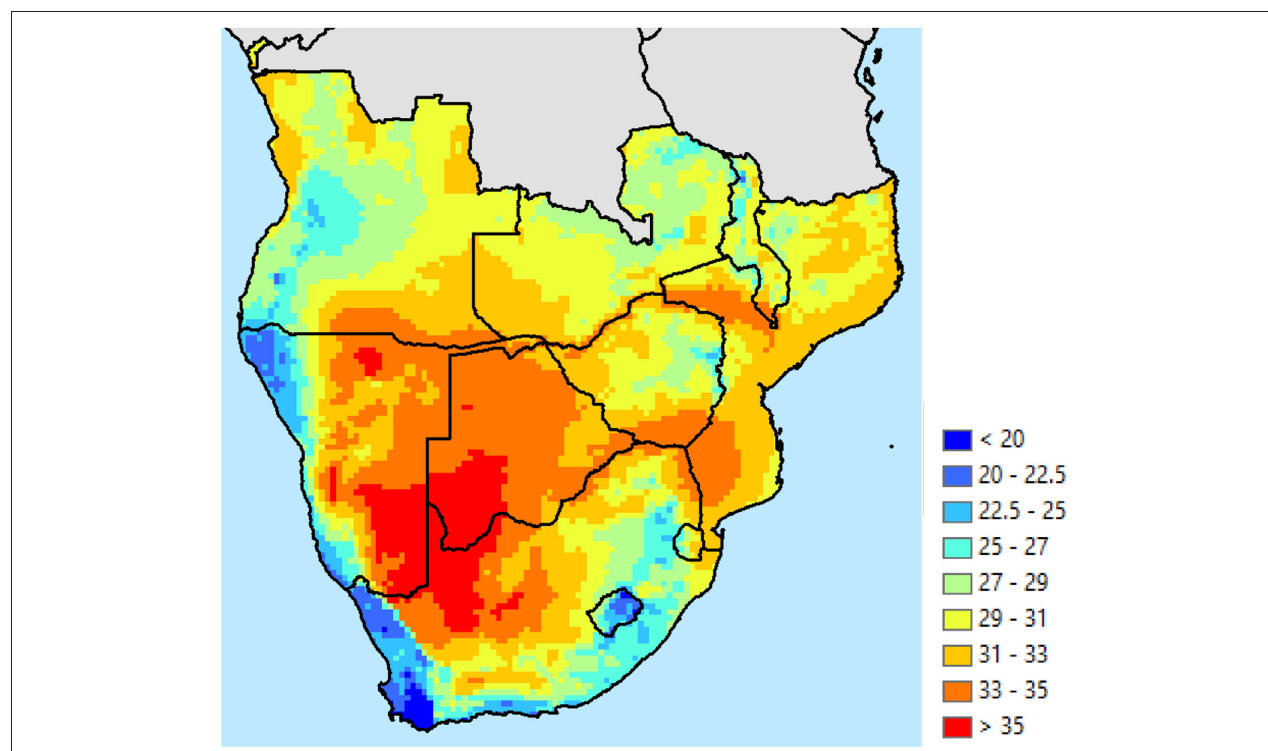
FIGURE 4 | Mean daily maximum temperature for the warmest month in the wettest 3 months, 0 C, 1981–2000. Source: Authors’ calculations based on Princeton Global Forcings, version 3 [2018, based on Sheffield et al. (2006)].